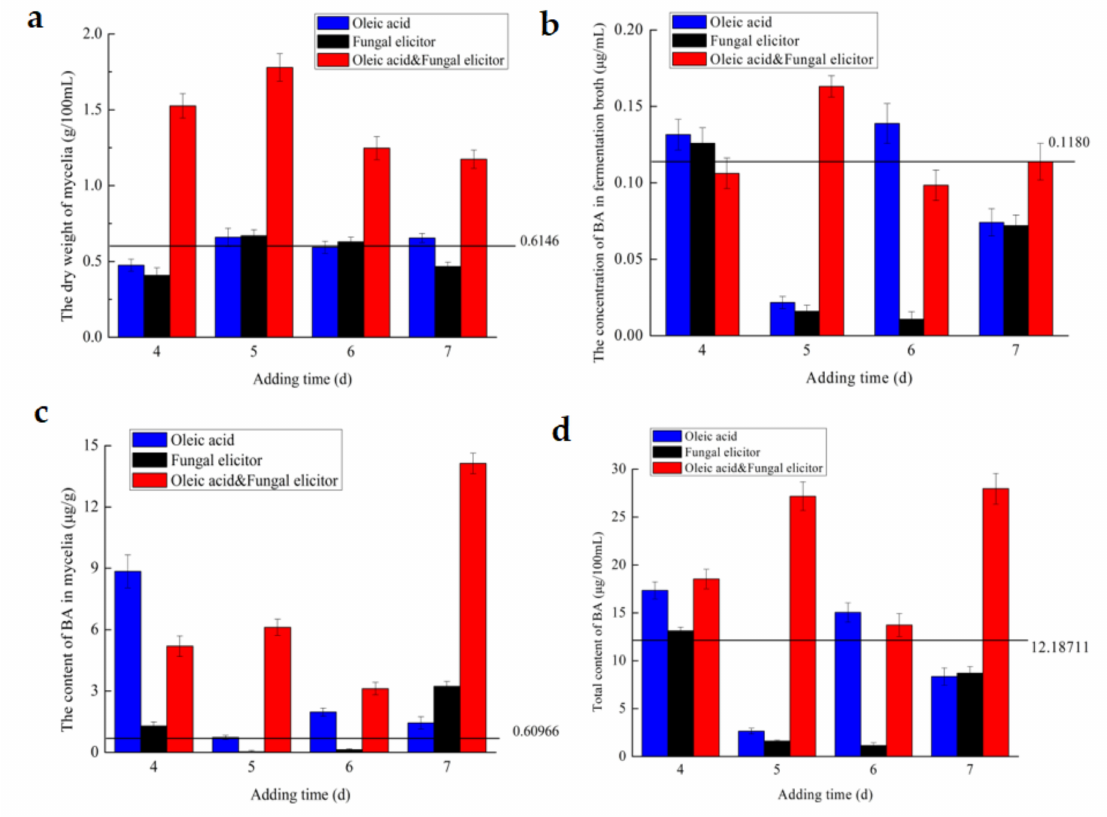
Figure 4. Effect of inducer’s adding time on mycelia’s dry weight ( a ), BA’s content in dry mycelia ( b ), BA’s concentration in fermentation broth ( c ) and BA’s total content ( d